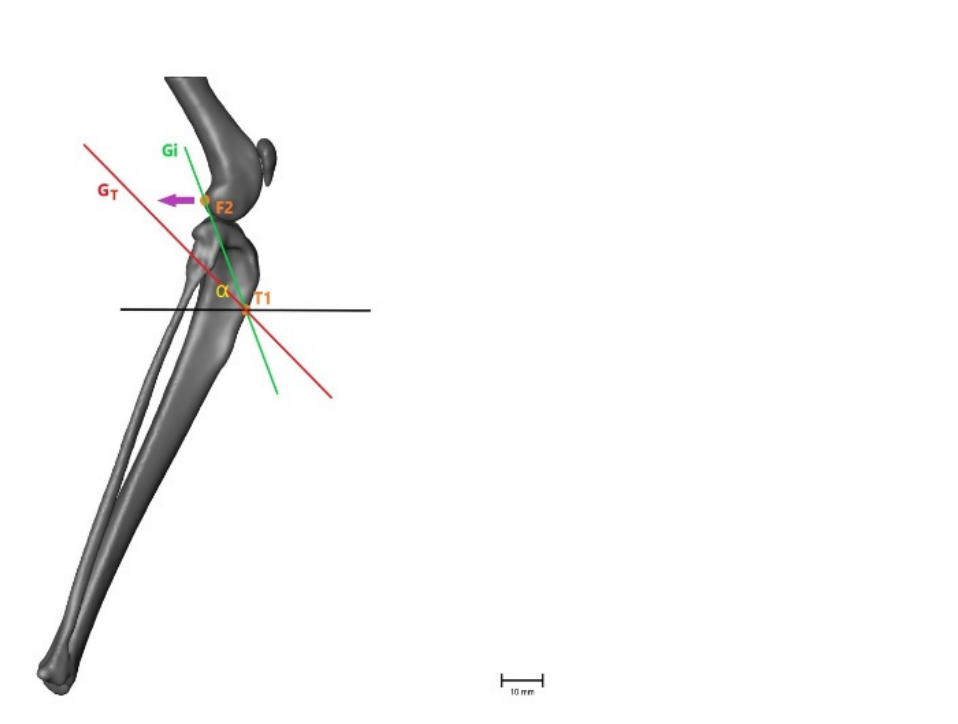
Figure 5. Illustration of the changes within the angle representing internal rotation of the tibia ( β ), showing that the angle becomes larger after CrCL transection as with internal rotation of the tibia